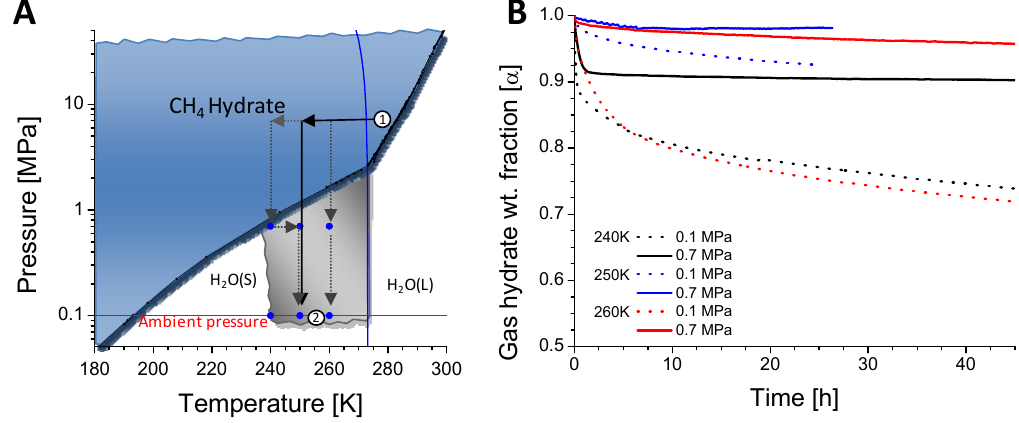
Figure 3. Main components influencing the existence and strength of the self-preservation effect. The fields outlined with dashed lines mark elements that are recognized to be important for the anomaly, but for which the underlying mechanisms are still